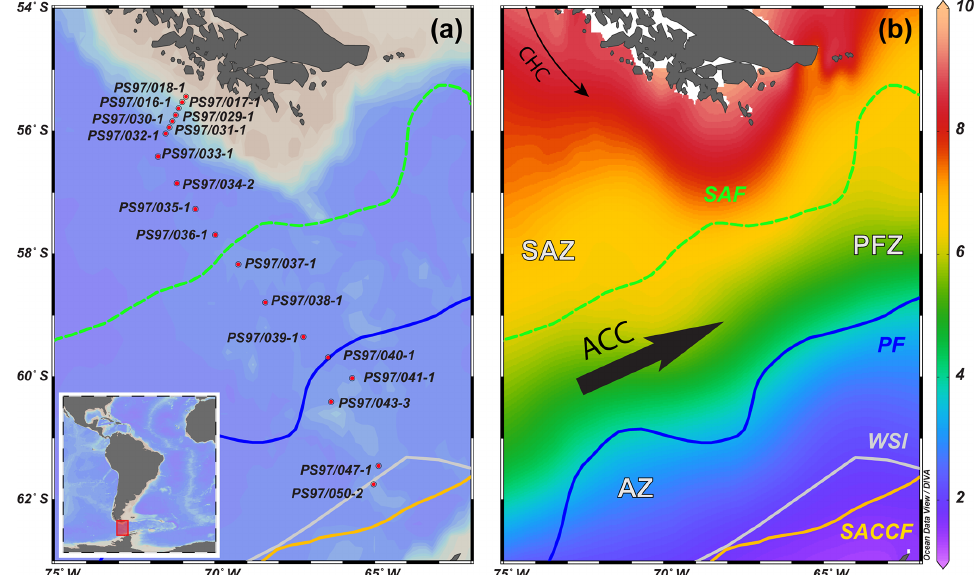
Figure 1. (a) Overview map showing the bathymetry of the Drake Passage area and the CTD stations studied; (b) sea-surface temperature ( ◦ C) seasonal average (January, February and March) at 0m water depth from the World Ocean Atlas 2013, 0.25 ◦ grid (Locarnini et al., 2013), plotted with Ocean Data View (ODV) software version 4.6.3 (Schlitzer, 2015). The different oceanographic fronts are indicated as follows: Subantarctic Front (SAF) with a green dashed line, Antarctic Polar Front (PF) with a blue line and southern Antarctic Circumpolar Current Front (SACCF) with a yellow line (Orsi et al., 1995). The areas between the fronts are referred to as Subantarctic Zone (SAZ), Polar Front Zone (PFZ) and Antarctic Zone (AZ). CHC is Cape Horn Current, ACC is Antarctic Circumpolar Current and WSI is winter sea ice extent (Comiso, 2003).